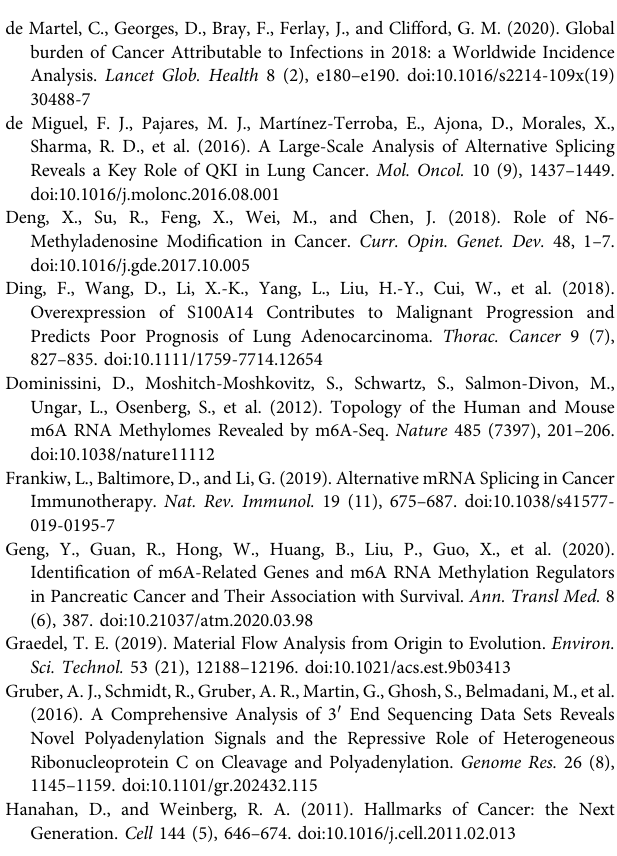
SUPPLEMENTARY FIGURE S2 | (A) TheclusterdendrogramoftheLUADpatients. (B) TheclusterdendrogramoftheLUSCpatients.LUAD,lungadenocarcinoma;LUSC, lung squamous cell carcinoma. SUPPLEMENTARY FIGURE S3 | Cluster analysis of samples in LUAD (A) and LUSC (B) in the detection of the outliers. The white-to-red linear gradient color indicates the association with the corresponding clinical variables, while the gray indicates missing data. LUAD, lung adenocarcinoma; LUSC, lung squamous cell carcinoma. SUPPLEMENTARY FIGURE S4 | Bioinformatical analysis of AS modules Associated with m6A RNA methylation regulatory genes. (A) The eigengene dendrogram and heat map. They identify groups of the correlated eigengenes termed meta-modules in LUAD. (B) Module – trait association in LUAD. Each row corresponds to a module eigengene, column to a trait. Each cell contains the corresponding correlation and p -value. The table is color-coded by correlation according to the legend. (C) The eigengene dendrogram and heat map. They identify groups of the correlated eigengenes termed meta-modules in LUSC. (D) Module – trait associations in LUSC. Each row corresponds to a module eigengene, column to a trait. Each cell contains the corresponding correlation and p -value. The table is color-coded by correlation according to the legend. LUAD, lung adenocarcinoma; LUSC, lung squamous cell carcinoma. SUPPLEMENTARY FIGURE S5 | The parameter of the adjacency function in the weighted gene correlation network analysis algorithm. (A) Analysis of the soft threshold powerandtheaverageconnectivityofvarioussoftthresholdpowersinLUAD. (B) Analysis of the soft threshold power and the average connectivity of the various soft threshold powers in LUSC. LUAD, lung adenocarcinoma; LUSC, lung squamous cell carcinoma. SUPPLEMENTARY FIGURE S6 | Scatterplot of the gene or clinical traits signi fi cance (the y-axis) vs. module membership (the x-axis) in the most signi fi cant module of LUAD (A) and LUSC (B) . In modules related to a trait of interest, genes with high module membership often also have had high gene signi fi cance. LUAD, lung adenocarcinoma; LUSC, lung squamous cell carcinoma.